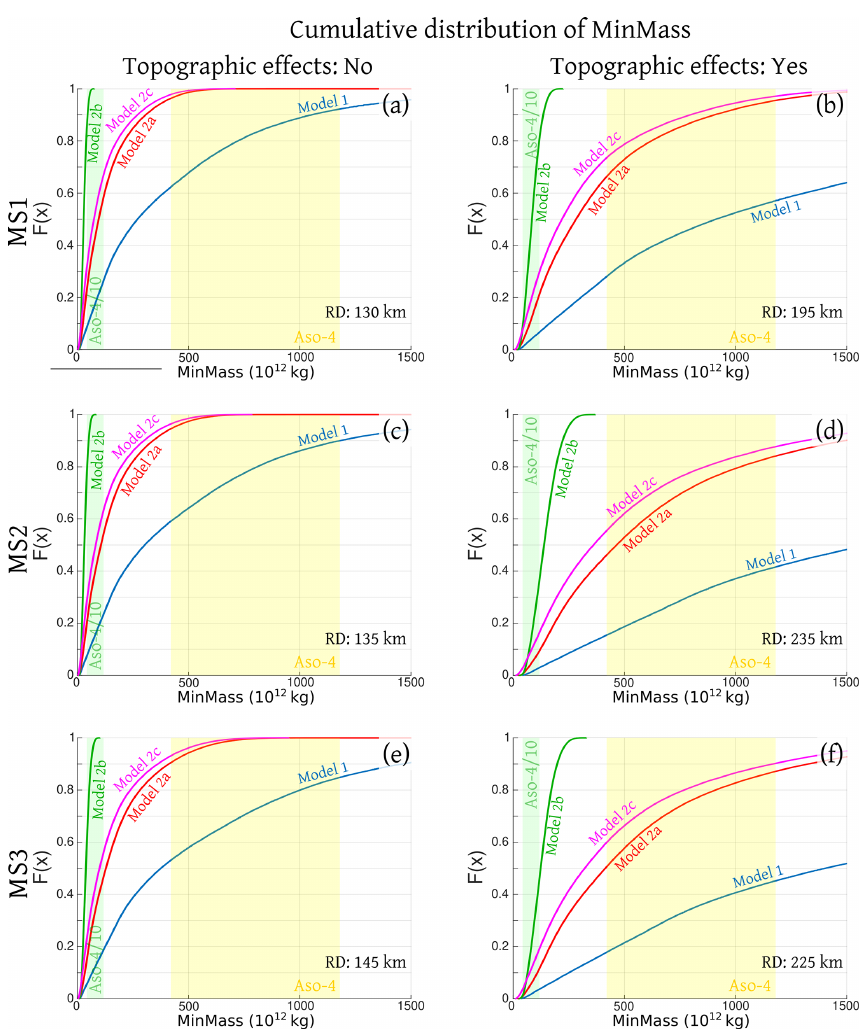
Figure 4. Cumulative distributions of the variable MinMass, calculated using models 1, 2a, 2b, 2c. MinMass represents the mass of pyroclasts in a PDC flow required to invade the different marker sites. (a, c, e) are related to maximum runout distances of 130, 135 and 145km, respectively (the distance between Aso caldera and the marker sites MS1–MS3). (b, d, f) are related to maximum runout distances of 195, 235 and 225km, respectively, allowing the flow to overcome possible topography shielding effects near the marker sites. Estimates of the mass associated with the PDCs produced during the largest caldera-forming eruption of Aso are included: Aso-4 / 10, plausibly representing the Aso-4T unit, in green; Aso-4, total PDC overflow, in yellow (Takarada and Hoshizumi, 2020). Plots are based on 100000 statistical